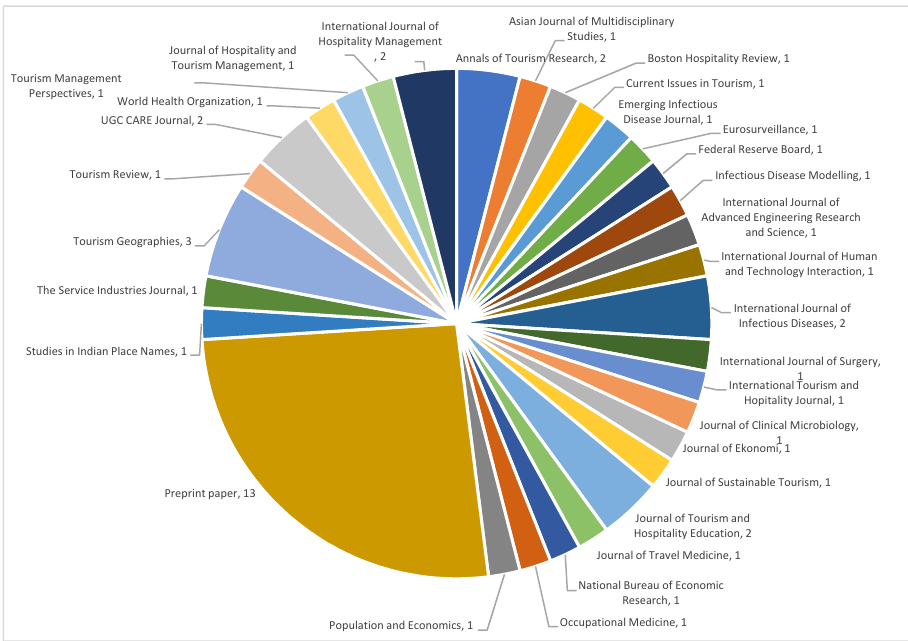
Figure 2. Publication source among included papers.